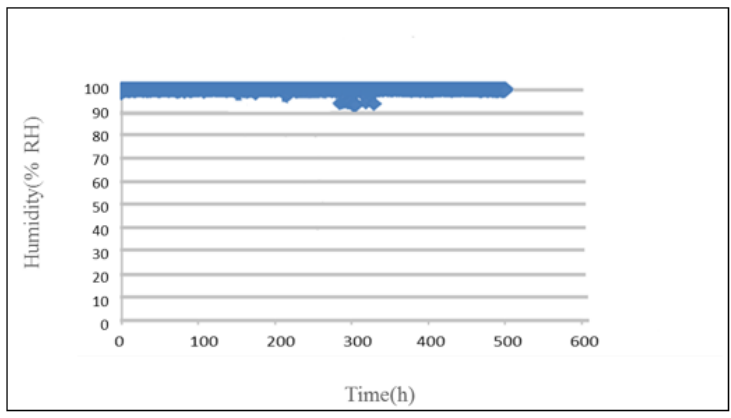
Figure 19. Curve of humidity inside PEM water electrolyzer. As the operating voltage is high (5V), the micro flow sensor is destroyed after 100 h, the flow inside PEM water electrolyzer cannot be monitored anymore, as shown in Figure 20.